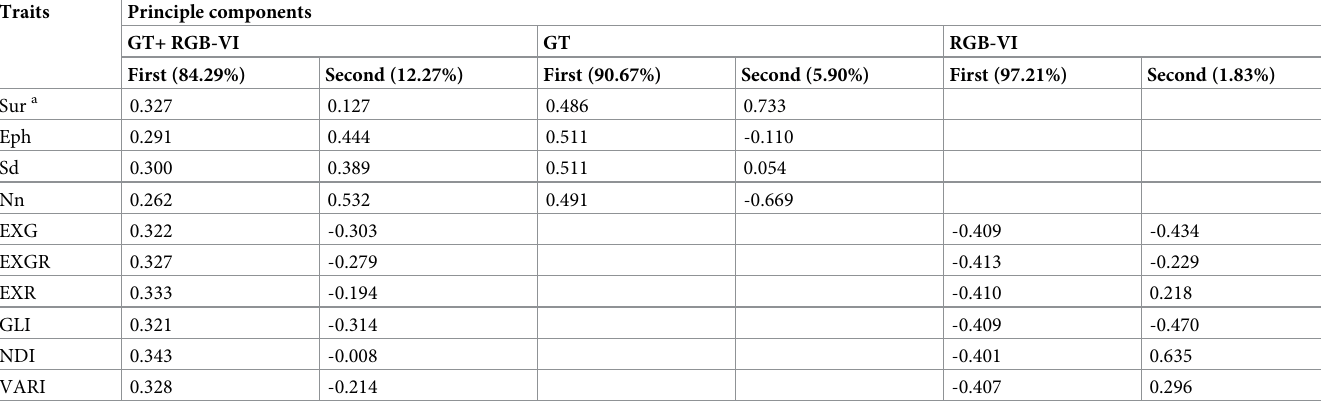
Table 7. The eigenvalues of the correlation matrix for four Growth Traits (GT) and 5 RGB-based growth index (RGB-VI) on 20 entries of kenaf.